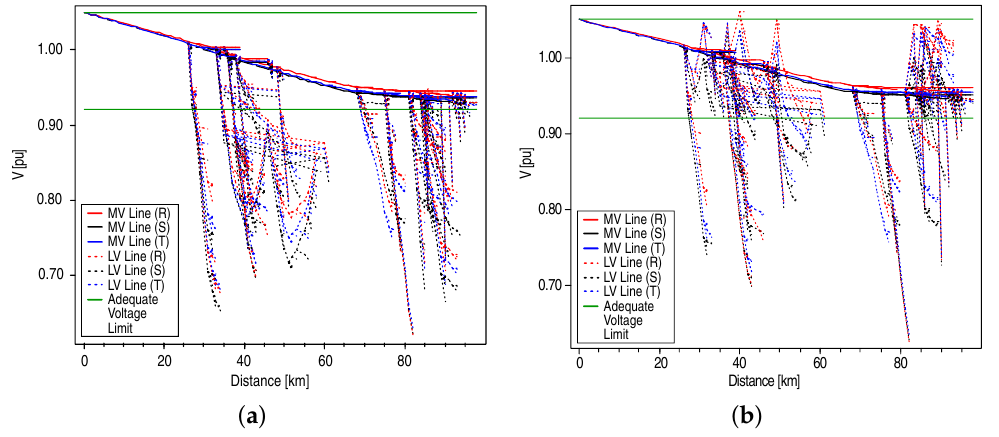
Figure 24. Optimization without bus restriction: ( a ) voltage profile before DGPV allocations and ( b ) voltage profile after DGPV